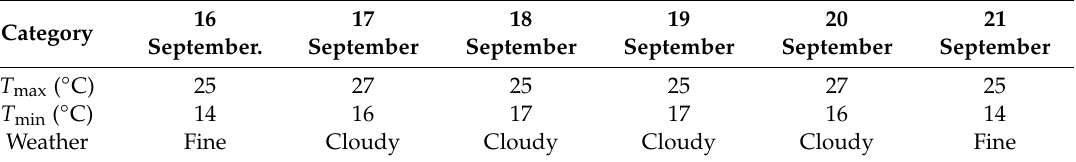
Figure 9. Energy use of the main device in statistical time period. Table 5. Specific meteorological parameters of analysis time period.